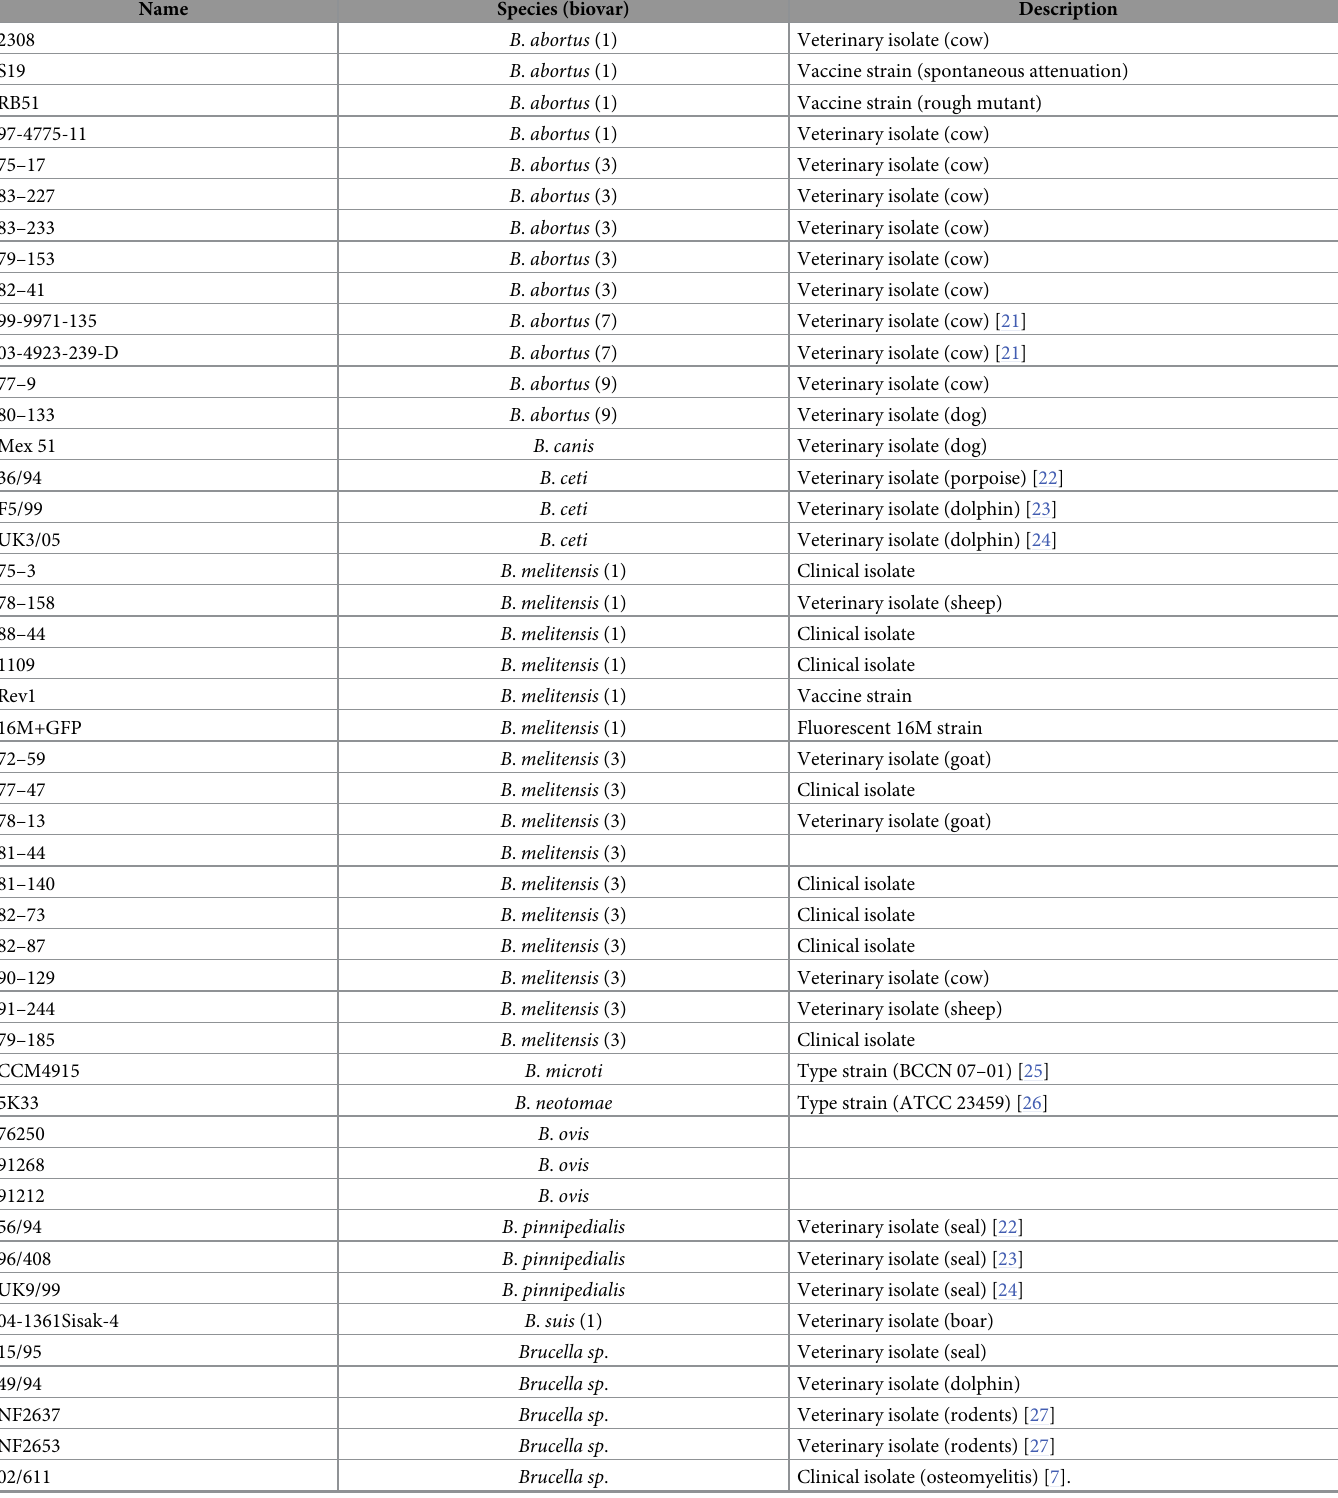
Table 2. Bacterial strains and isolates used for external validation of the